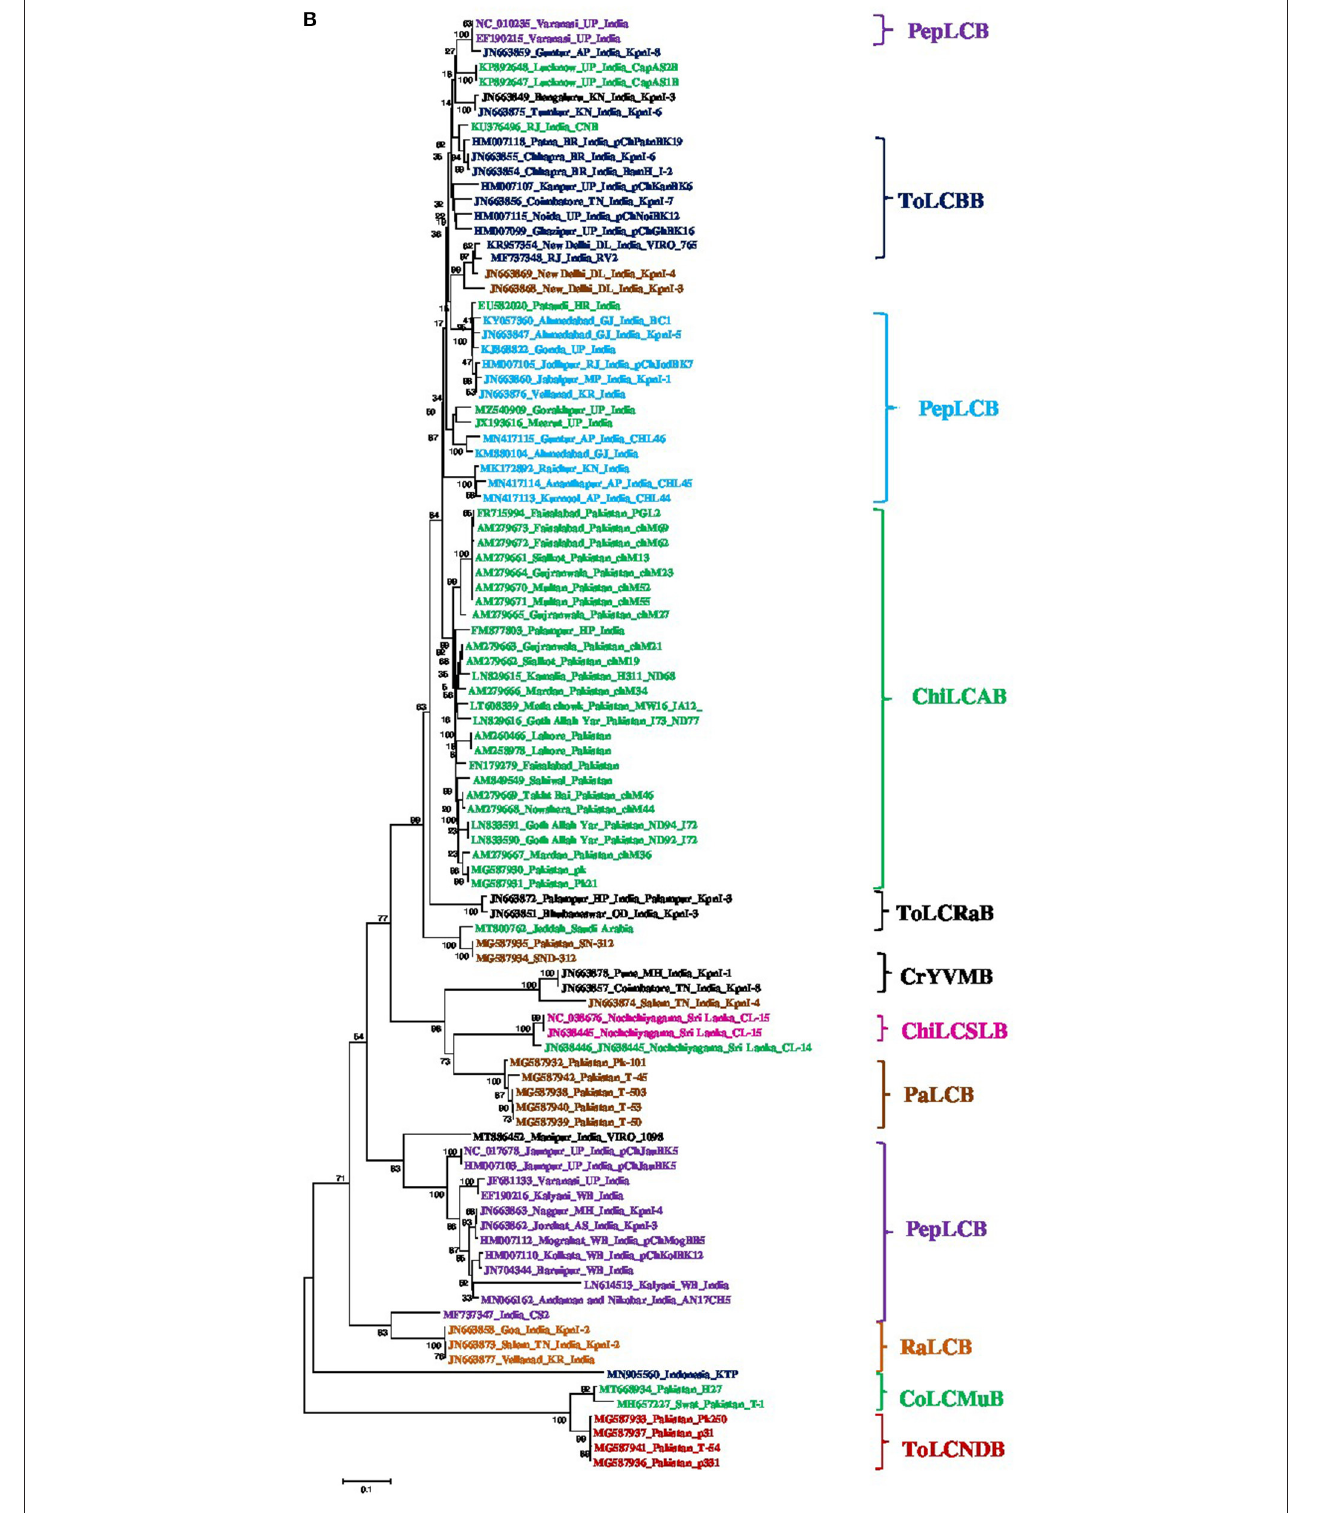
FIGURE 4 | Phylogenetic dendrogram of begomoviruses (A) and betasatellites (B) associated with chili leaf curl disease (ChiLCD) in chili based on Neighbor-Joining method. The reference genome sequences were retrieved from NCBI GenBank for comparisons. Initially, the nucleotide sequences were aligned using Clustal W multiple alignment with bootstrap values of 1,000 replicates which are mentioned at the nodes. Major clades indicated in the specific color that belongs to the same or related species indicated at the right side of the each clade. The scale bar represents the rate of nucleotide substitutions per site.